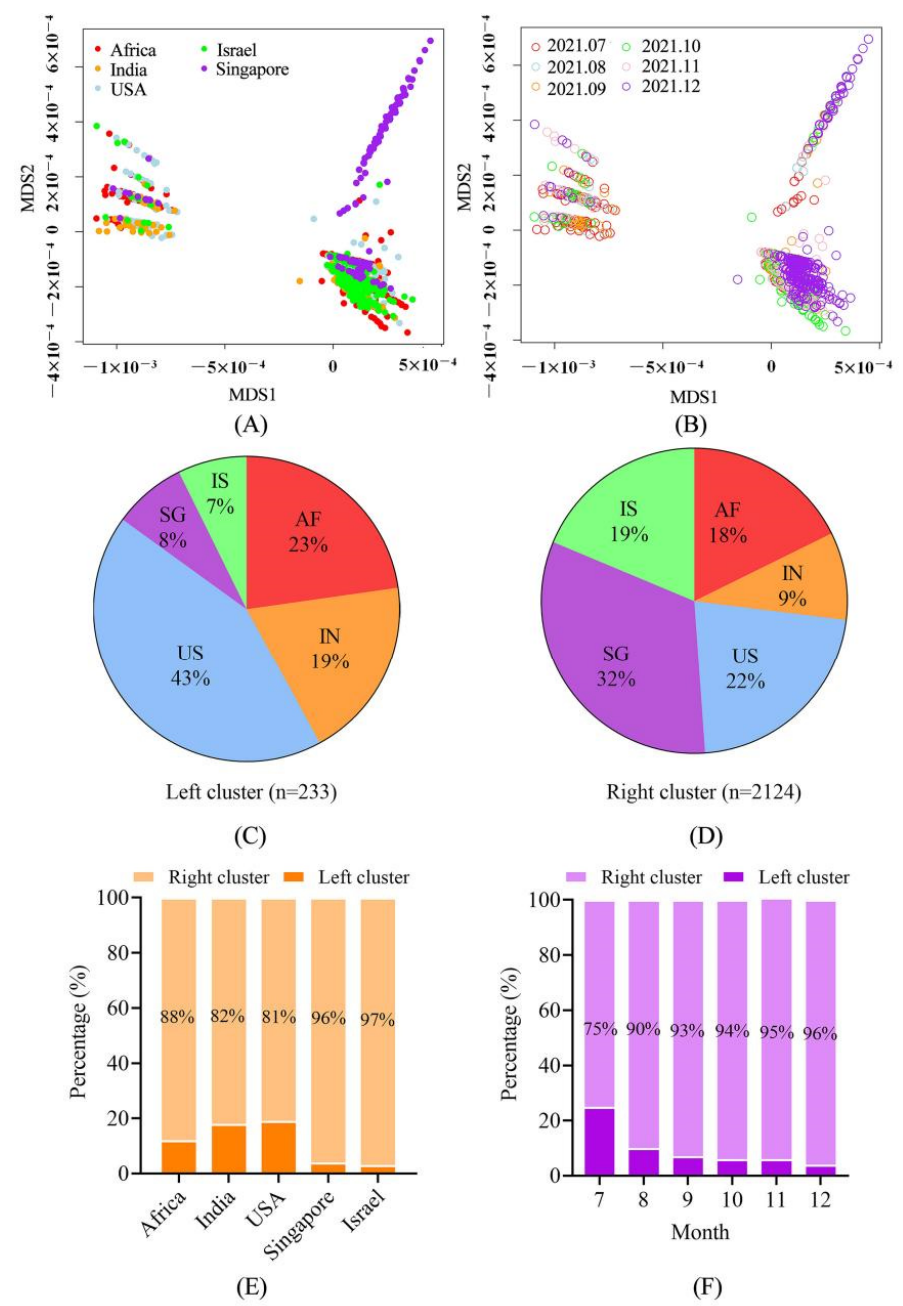
Figure 1. Genetic signatures and spatial-temporal distribution of the sequences. ( A , B ) Sequence clustering by multidimensional scaling (MDS) analysis. The sequences were grouped into R and L clusters, and the two clusters contained the sequences collected in different areas across different months. ( C – E ) Geographical distribution of the sequences in R and L clusters. Israel and Singapore contained much larger proportions of the R cluster than other countries. ( F ) Temporal distribution of the sequences in R and L clusters. The proportion of the L cluster decreased over time. AF, Africa; In, India; US, USA; SG, Singapore; IS, Israel.